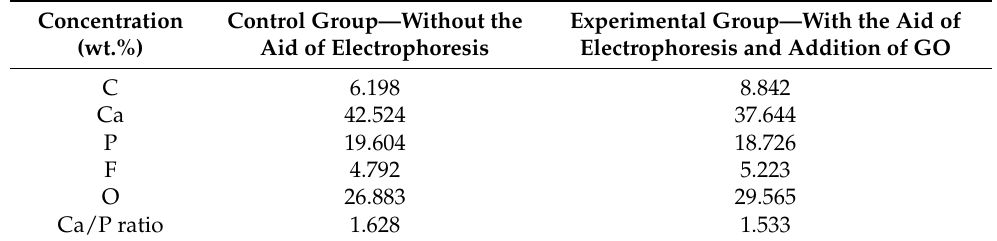
Table 1. Average concentration (wt.%) of control group (without the aid of electrophoresis) and experimental group (with the aid of electrophoresis) with addition of GO. Concentration Control Group—Without the Experimental Group—With the Aid of (wt.%) Aid of Electrophoresis Electrophoresis and Addition of GO C 6.198 8.842 Ca 42.524 37.644 P 19.604 18.726 F 4.792 5.223 O 26.883 29.565 Ca/P ratio 1.628